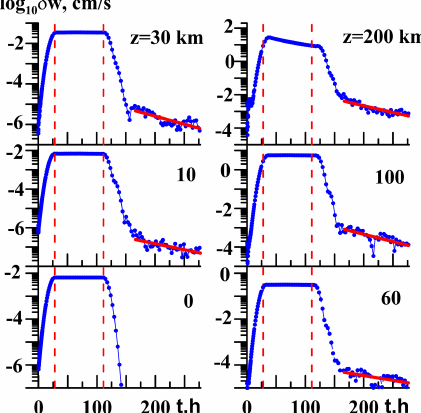
Figure 4. Same as Fig. 2, but for the surface wave source (Eq. 5) at c x = 100ms − 1 and W 0 = 0.1mms − 1